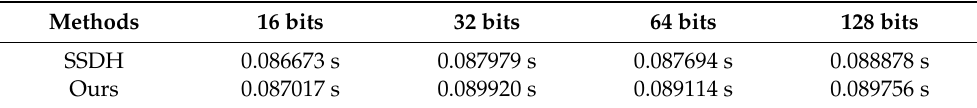
Table 5. Encoding time on visual